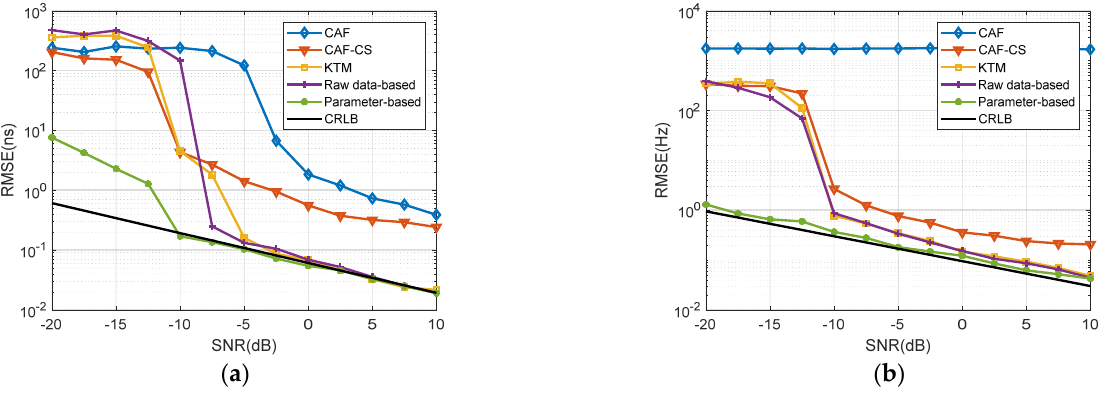
Figure 10. RMSEs of five methods. ( a ) RMSE of the TDOA estimation, ( b ) RMSE of the FDOA estimation.